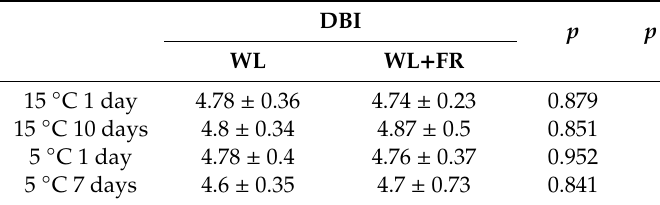
Table 3. Total lipid double-bond index in barley leaves grown at 15 ◦ C for 1 and 10 days and in leaves grown at 5 ◦ C for 1 and 7 days under WL and WL + FR.